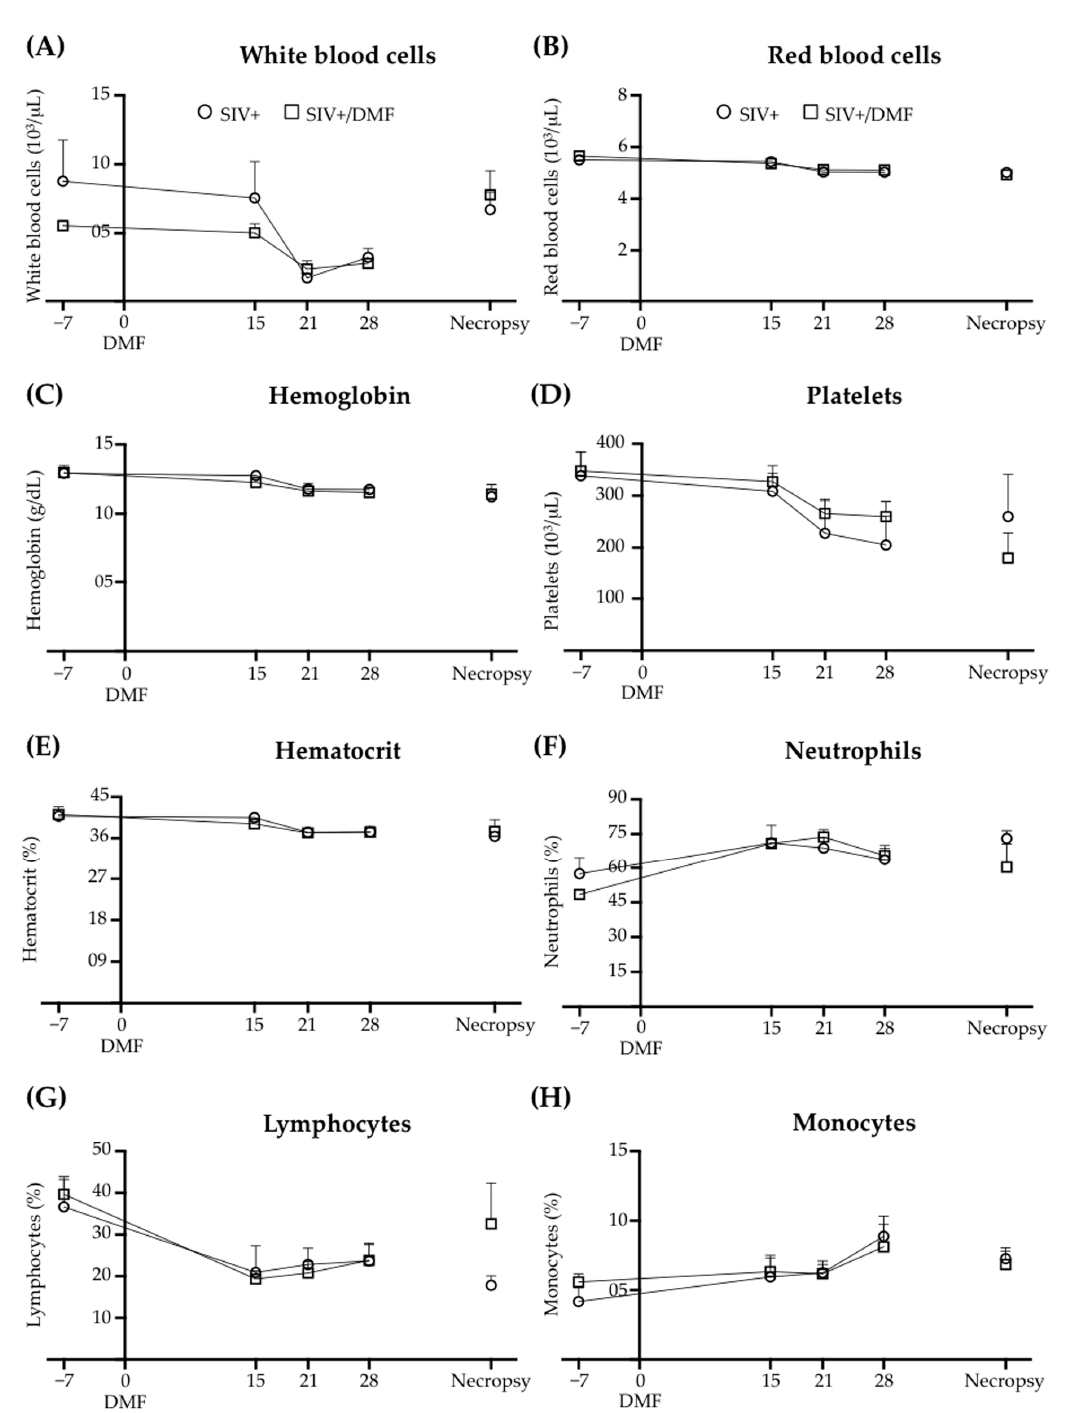
Figure 9. DMF treatment did not associate with changes in blood cell counts. ( A ) White blood cell count. ( B ) Red blood cell count. ( C ) Hemoglobin level. ( D ) Platelet count. ( E ) Hematocrit level in total blood. ( F ) Percent of neutrophils from total white cells. ( G ) Percent of lymphocytes from total white cells. ( H ) Percent of monocytes from total white cells. Blood parameters were assessed at time points (days) from the day of initiation of the DMF treatment. Each point represents the average for each treatment group at that time point. Nine SIV-infected rhesus macaques were used in the study (4 untreated animals and 5 DMF-treated (90 mg total DMF daily)). All values are expressed as mean ±